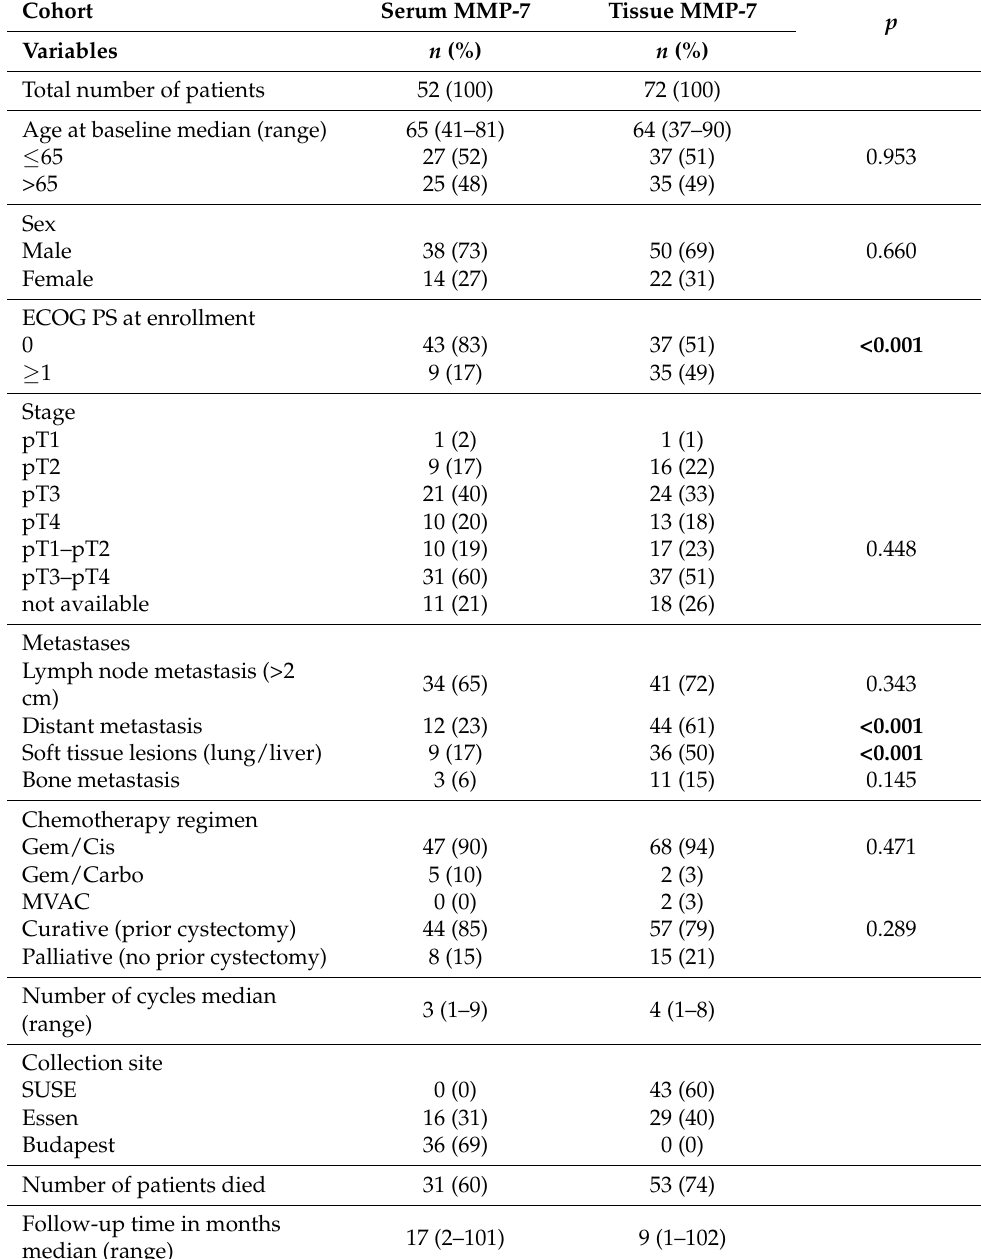
Table 1. Patients’